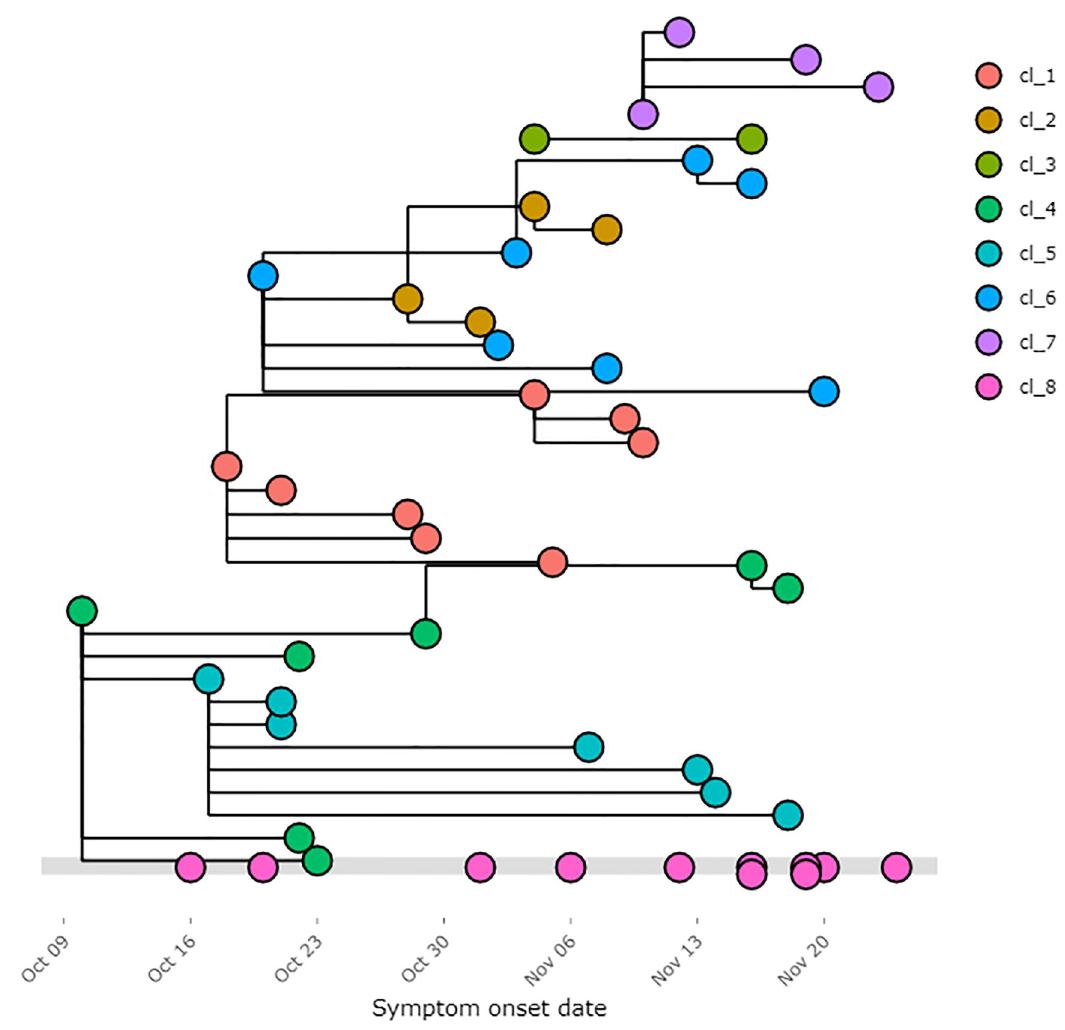
Fig 2. Extended transmission tree with symptom onset dates as entered. These are visualised using the online shiny app using data from RECON learn. Note, the colour of the node can depend on any entered field from the linelist, as specified by the user, in this example it depends on the cluster